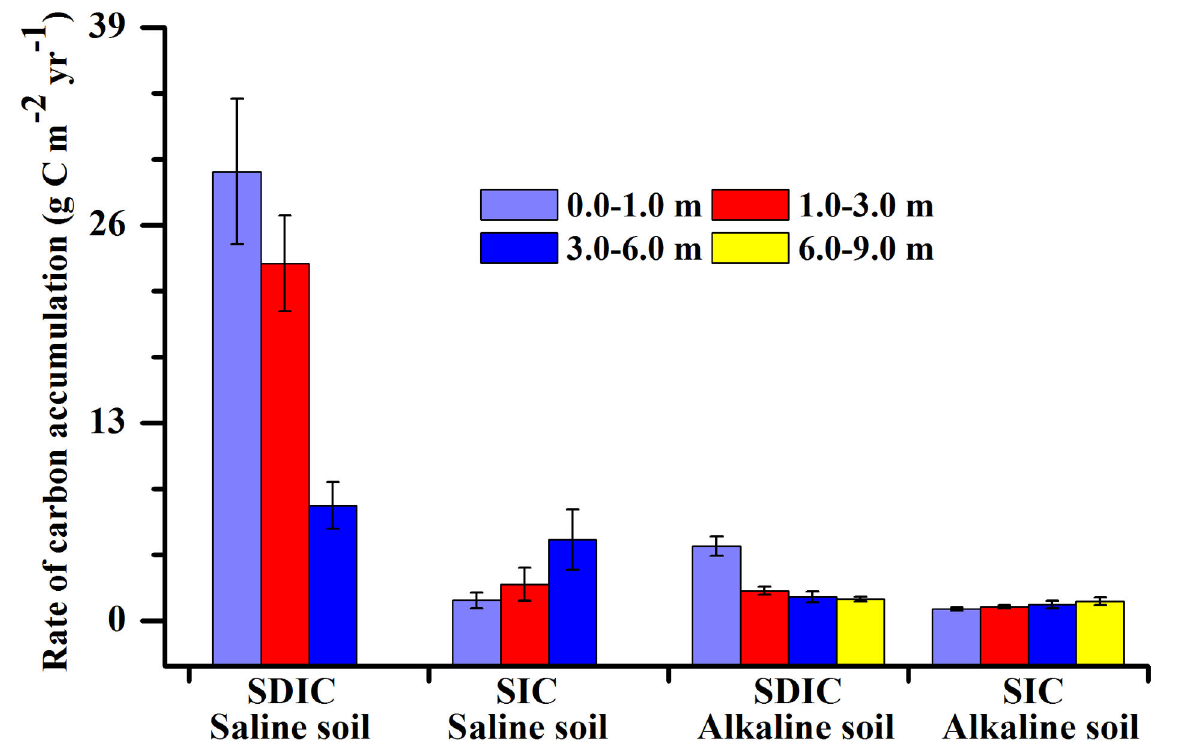
Figure 5. Mean rate of SIC and SDIC accumulation and standard error at different soil layers in the saline and alkaline soil